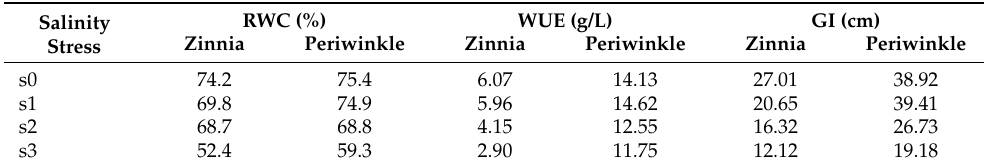
Table 4. Relative water content (RWC, %) and water use efficiency (WUE, g/L) and growth index (GI, cm) of zinnia and periwinkle with different salinity treatments (s0 = control; s1 = 3 dS/m; s2 = 4.5 dS/m; s3 = 6 dS/m).